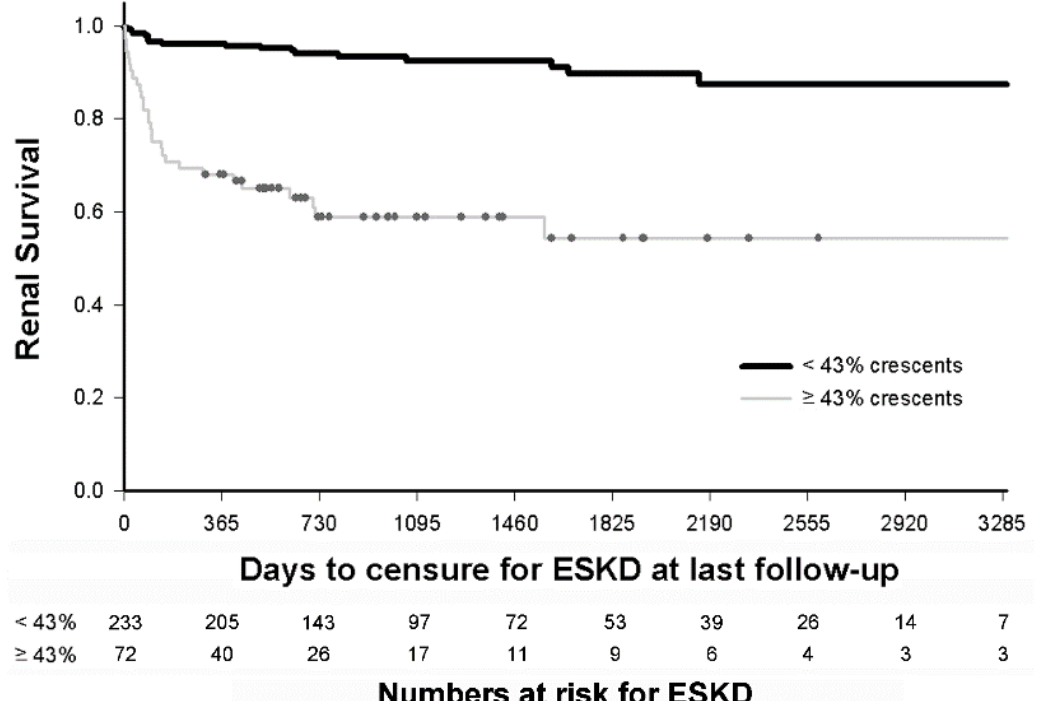
Figure 4. Predicting long-term renal survival in children with glomerulonephritis with crescents. Kaplan Meier survival analysis demonstrates that children with glomerulonephritis and ≥ 43% crescents (n = 72) have decreased survival than children with <43% crescents (n = 233), at a median